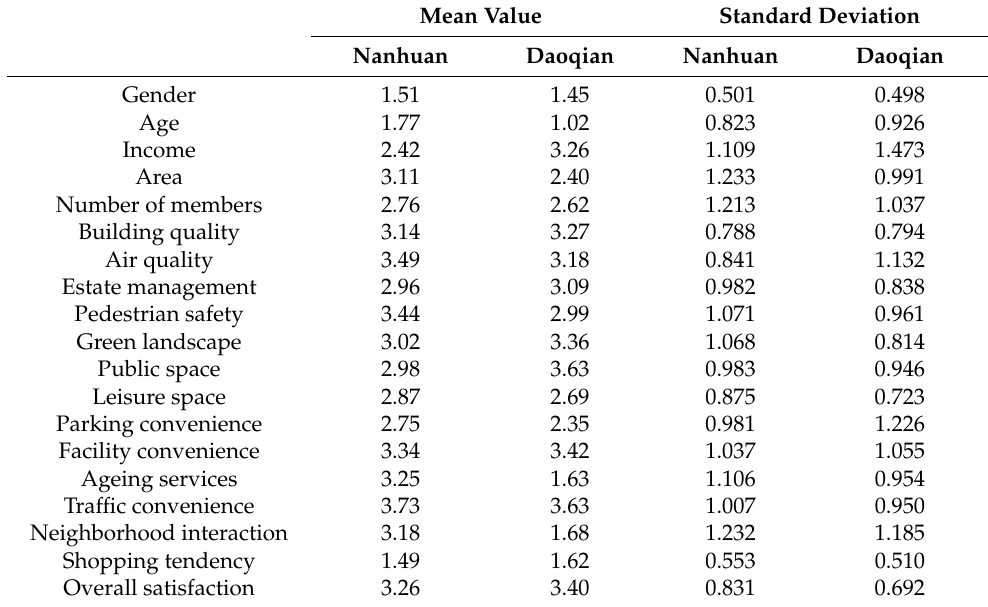
Overall satisfaction: In Nanhuan new village, scores of 3 and 4 out of 5 were reported by 45.2% and 45.5% of respondents, respectively. The satisfaction scores of Daoqian com- munity were mainly 2, 3, and 4, accounting for 14.2%, 47.3%, and 30.9%, respectively. Table 4. Questionnaire analysis. Table 4. Questionnaire analysis.